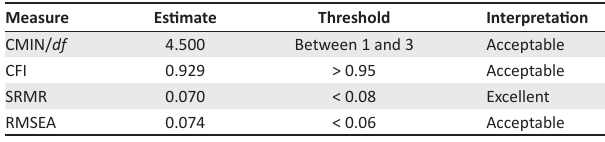
Table 5: Model-fit index.